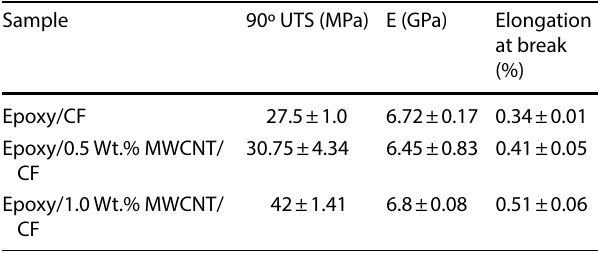
Fig. 6 The 90º tensile stress– strain curves of manufactured epoxy/MWCNT/CF hybrid nanocomposite with 0, 0.5, and 1.0 Wt.% MWCNTs